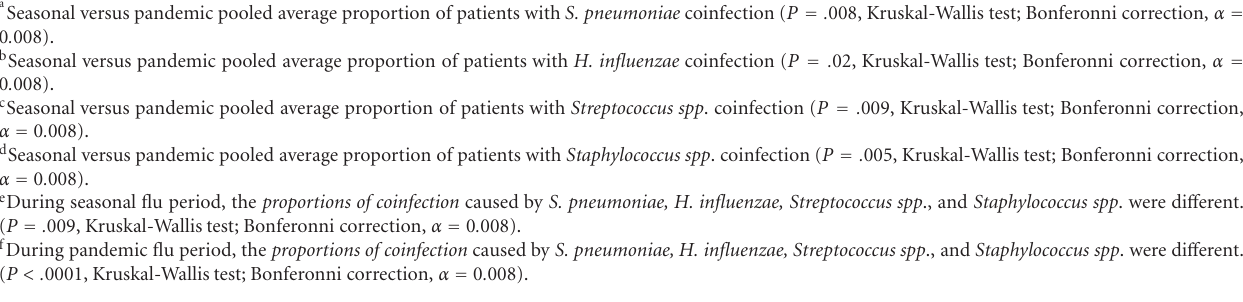
Table 3: Comparison of coinfection with major bacterial pathogens and influenza by pandemic period ( n = 56) a,b . Estimates from random e ff ects model Bacteria Pandemic period Studies ( n ) Average % coinfection with influenza virus